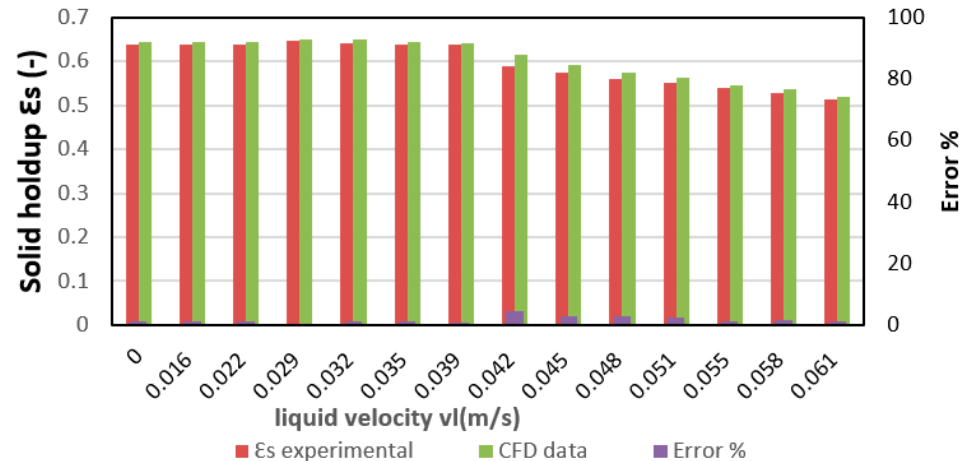
Figure 12. Comparisons between CFD simulation results and experimental data of solid holdup for particles with a diameter of 4 mm for different superficial liquid velocities.